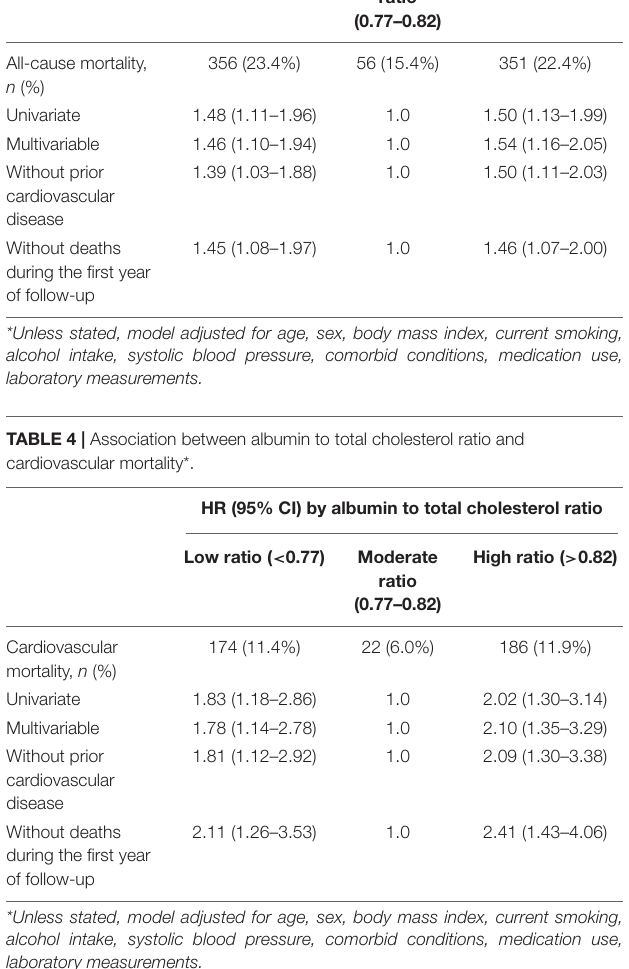
TABLE 3 | Association between albumin to total cholesterol ratio and all-cause mortality*. HR (95% CI) by albumin to total cholesterol ratio Low ratio ( < 0.77)